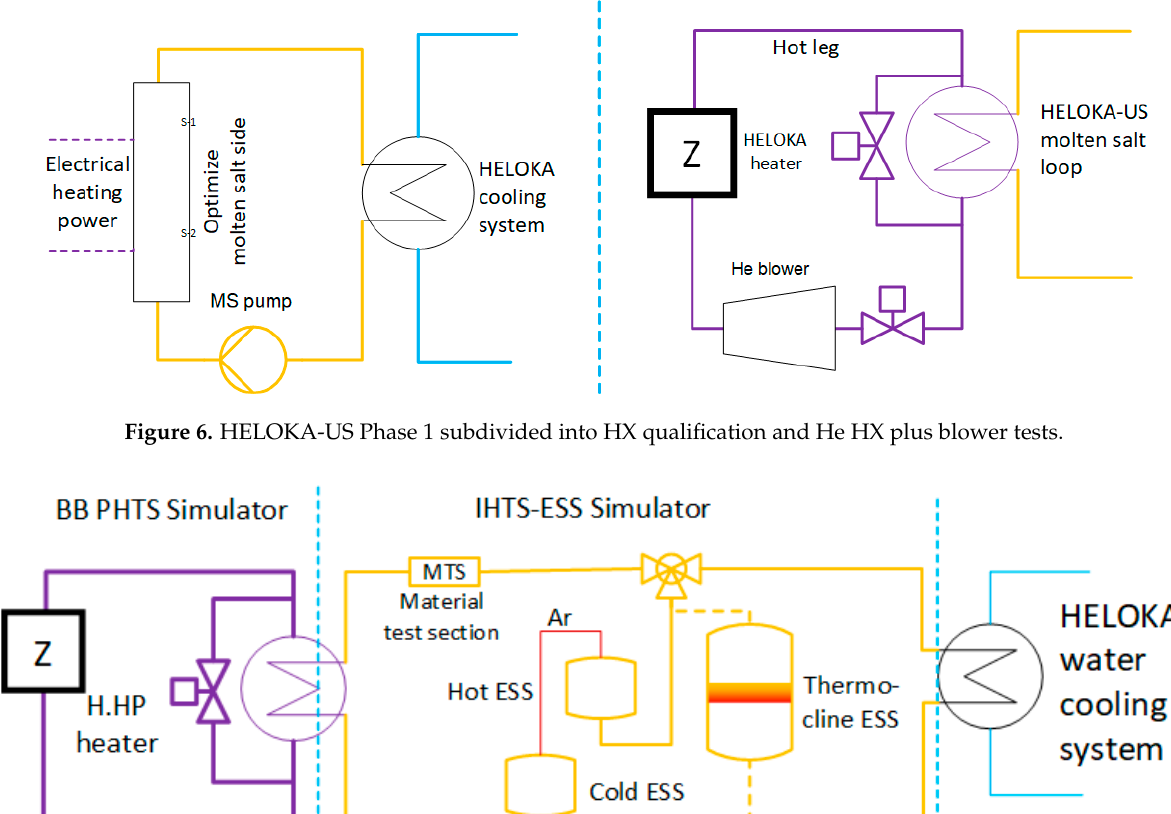
Figure 6. HELOKA-US Phase 1 subdivided into HX qualification and He HX plus blower tests.